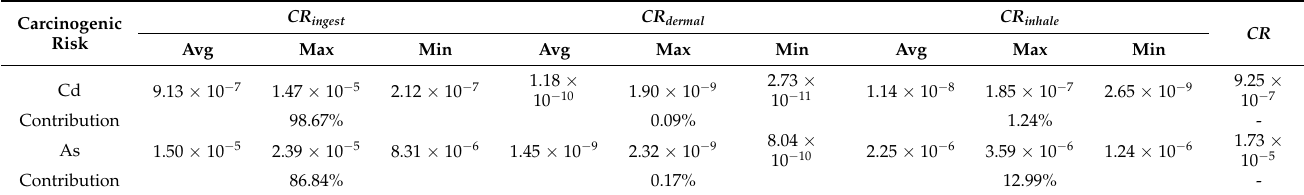
Table 2. Cancer risk of Cd and As by three exposure routes from the soil around the